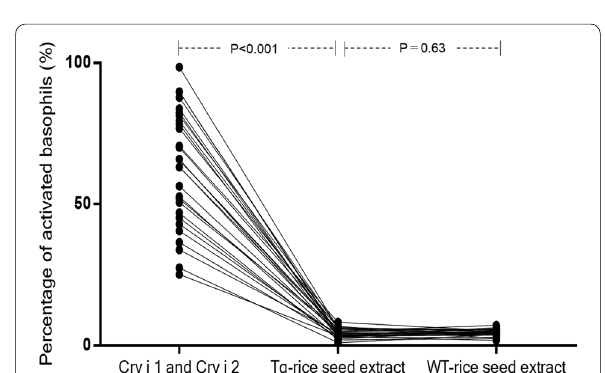
Fig. 4 The percentage of activated basophils in 29 patients with JC pollinosis. The percentage of CD203c-positive activated basophils after the stimulation with Tg-rice seed extract was 4.5 1.6% ± compared to 62.9 20.2% after the stimulation with the mixture ± of Cry j 1 and Cry j 2, and this difference was significant (difference 58.4%, P < 0.001, 95% confidence interval 51.0–65.9%). There was no significant difference between Tg-rice seed extract (4.5 1.6%) and ± WT-rice seed extract (4.6 1.2%) (difference 0.2%, P 0.63, 95% ± − = confidence interval 0.8% to −